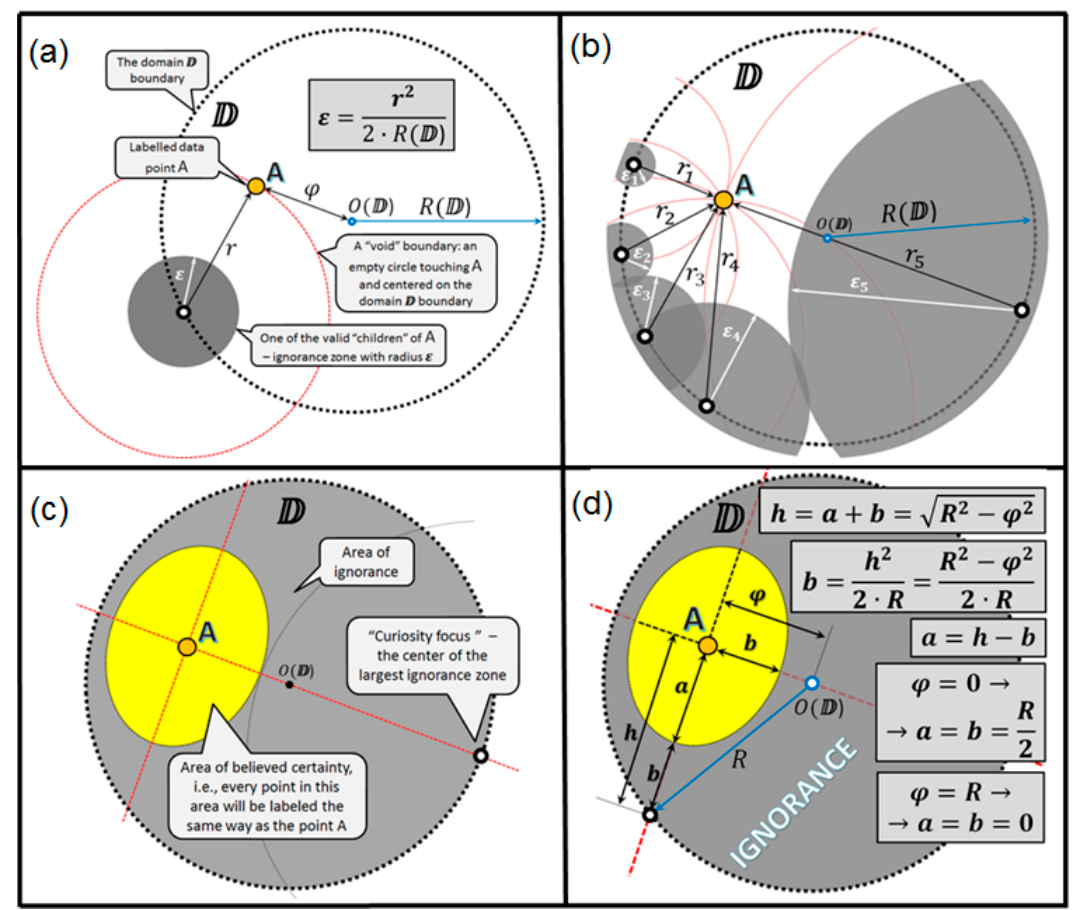
Figure 9. Illustration of the origin and parameters of the believed certainty and the ignorance areas around point A within the domain: ( a ) ignorance zone produced by one void; ( b ) ignorance zones produced by some other voids; ( c ) ignorance zones are merged so that the clear (elliptic) boundary is seen between the ignorance and certainty areas; ( d ) computations for the boundary between the ignorance and certainty.